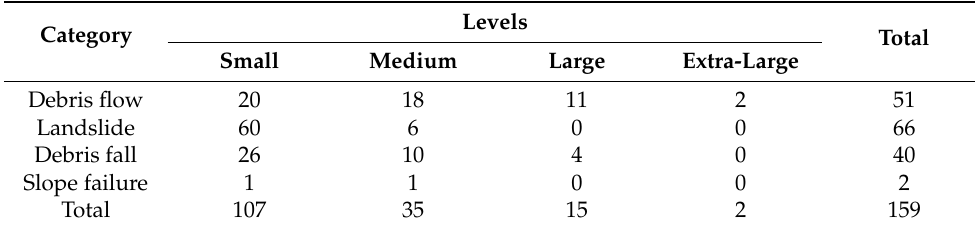
Table 1. Co-seismic and post-seismic potential geohazards in Longmenshan Town.